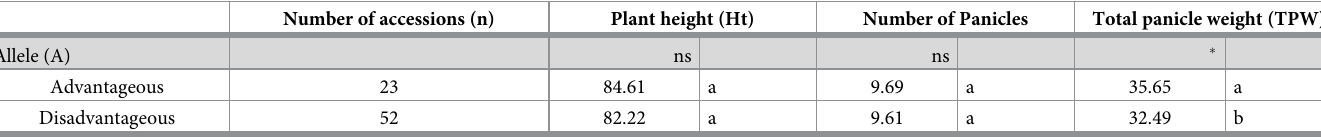
Table 4. Total panicle weight from rice accessions selected from within and outside the GWAS panel. Number of accessions